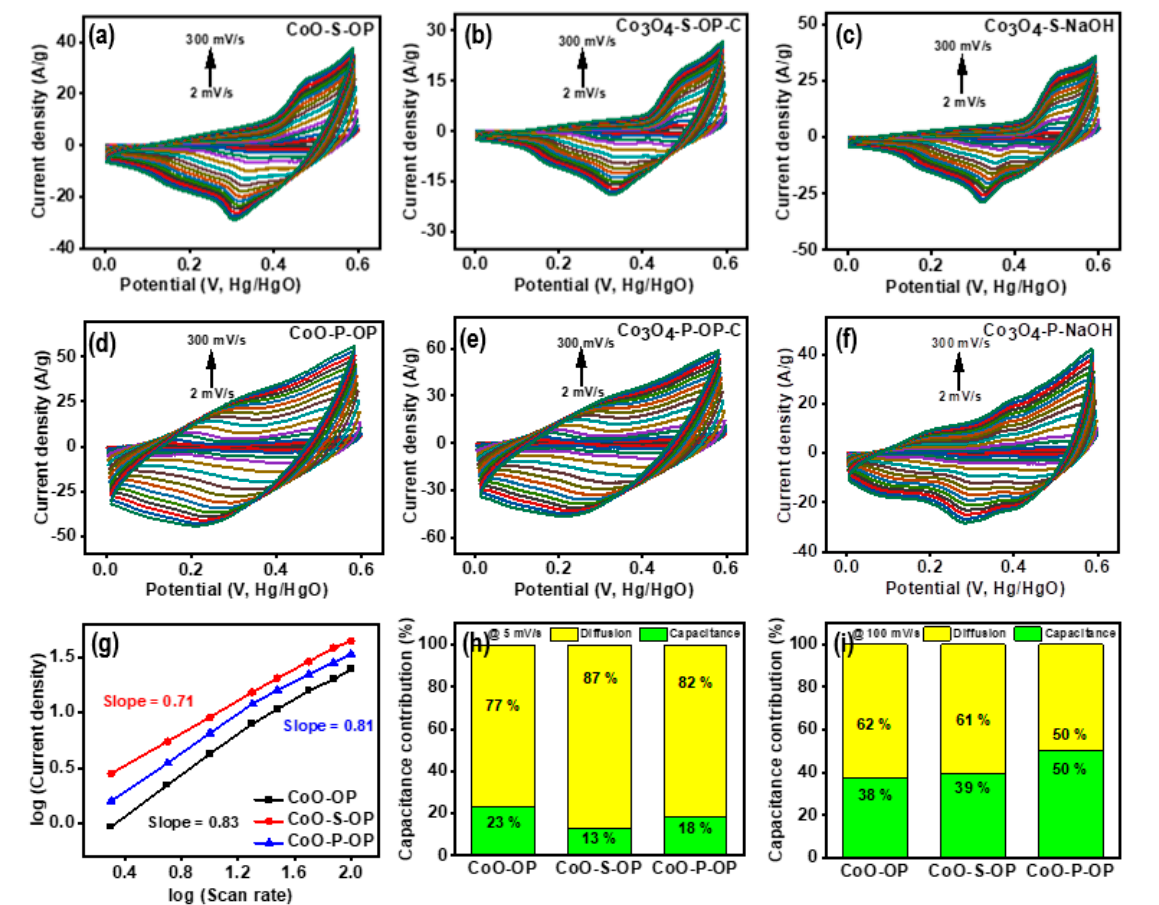
Figure 4. The CV scan curve from 2 to 300 mV/s for prepared ( a ) Co 3 O 4 -S-OP, ( b ) Co 3 O 4 -S-OP-C, ( c ) Co 3 O 4 -S-NaOH, ( d ) CoO-P-OP, ( e ) Co 3 O 4 -P-OP-C, ( f ) Co 3 O 4 -P-NaOH nanoparticles, and ( g ) log (current) versus log (scan rate) plot, ( h , i ) diffusion and capacitance contribution for CoO-OP, CoO-S-OP, and CoO-P-OP at a scan rate of 5 mV/s and 100 mV/s, respectively.